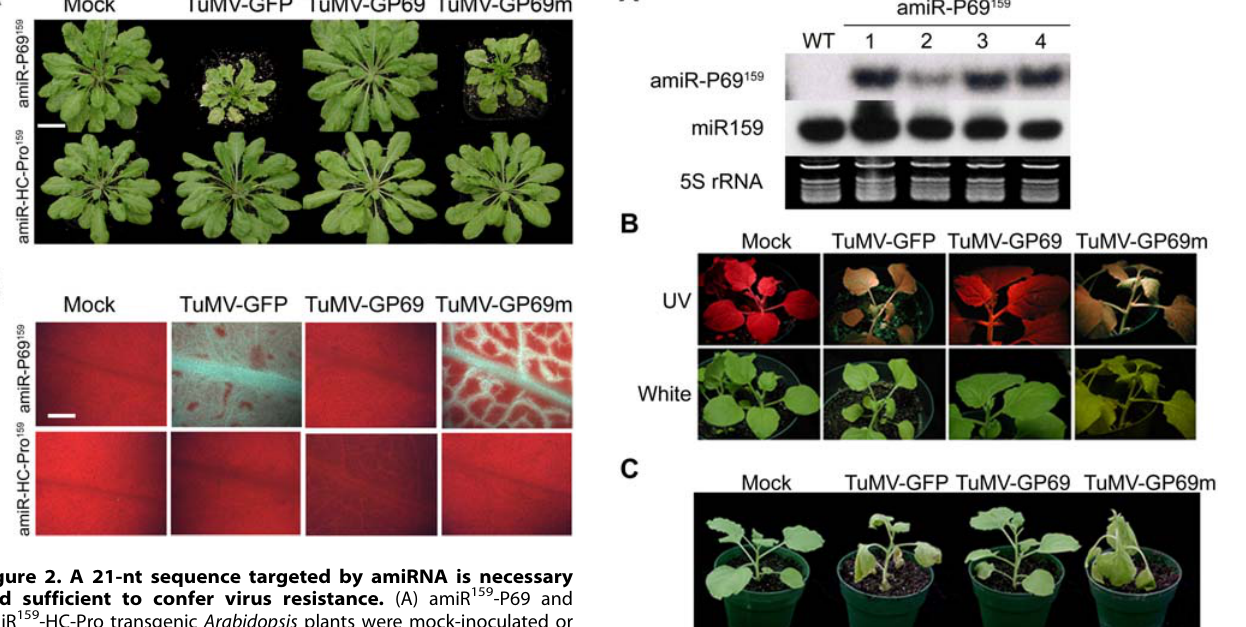
Figure 4C assigns mutants to the different clusters. The first cluster (green bars in Fig. 4C), is characterized by positions causing low pathogenicity, with an average value of 6.91 6 0.59%, suggesting that these sites are non critical for resistance. These low pathogenicity mutants are scatter along the entire 21-nt region. The second cluster contains mutants of intermediate pathogenicity (yellow bars in Figure 4C), with an average value of 36.36 6 4.71%, suggesting that these positions are moderately important for amiRNA-mediated resistance. Most of these medium effect mutants are located between nucleotides 10 and 18, with the exception of m2, which is located at the 3 9 end of the target sequence. Finally, the third cluster contains those mutants with a greater likelihood of resistance breakdown (red bars in Figure 4C). On average, these large effect mutants have 81.85 6 4.14%